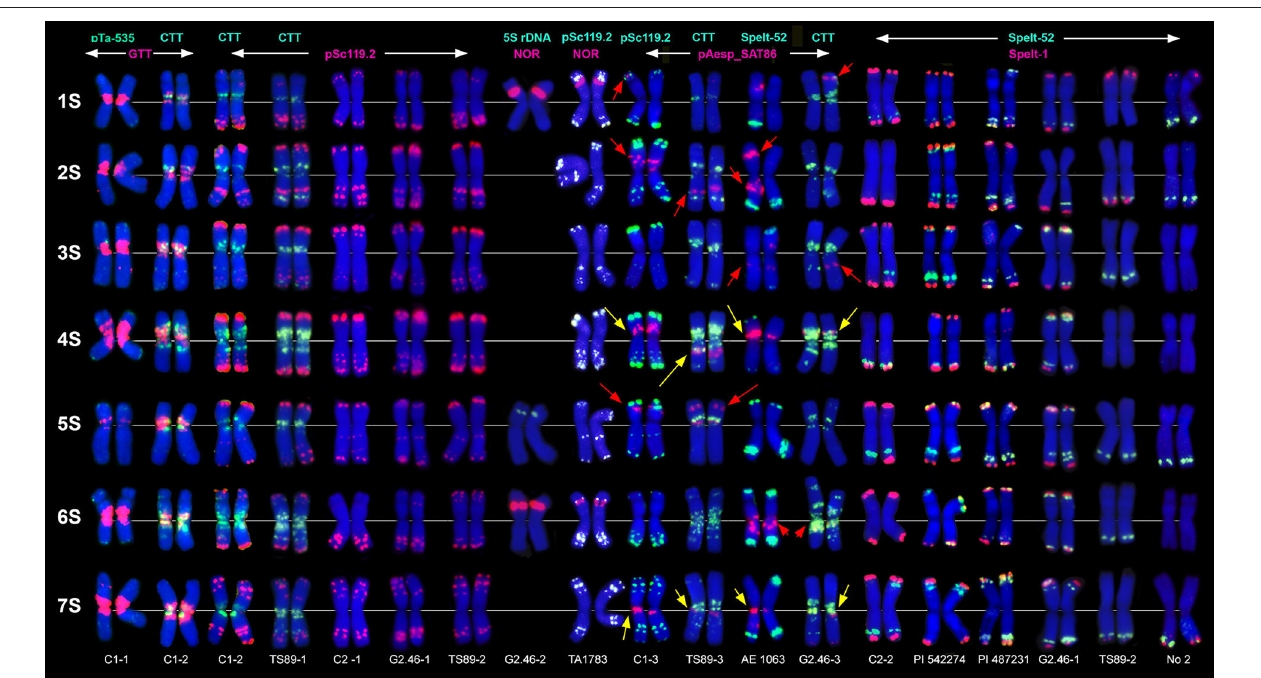
FIGURE 1 | Localization of different DNA sequences on chromosomes of Ae. speltoides. Probe combinations are shown on the top; signal color corresponds to probe name. Accessions numbers are indicated in the bottom: C1-1–C1-3 genotypes from Technion park, Haifa, Israel; TS89-1–TS89-3–genotypes from Katzir, Israel; C2-1–C2-2–genotypes from Nahal Mearot, Israel; G2.46-1–G2.46-3–genotypes from Ramat haNadiv, Israel. Permanent pAesp_SAT86 loci are indicated with yellow arrows; polymorphic sites are shown with red